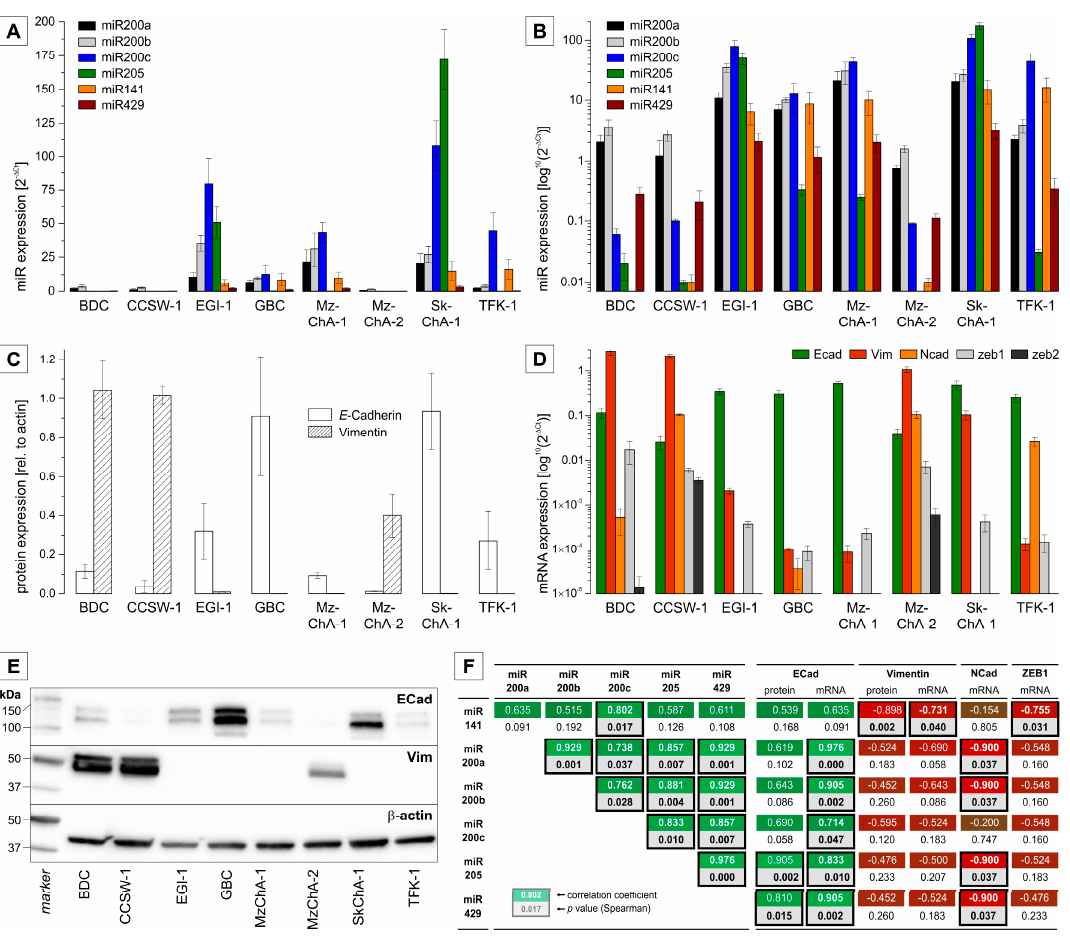
Figure 1. Relative expression of miR200 family members, miR205 and EMT-related markers (mRNA, protein) in BTC cell lines. ( A , B ) expression levels of miRs related to RNU6B using a linear ( A ) and a logarithmic ( B ) scale, respectively; ( C ) quantitative protein expression (densitometry) of epithelial marker E -cadherin and mesenchymal marker vimentin; ( D ) mRNA levels of EMT markers related to β -actin; ( E ) representative Western blot images (cropped); ( F ) Spearman correlation analysis of miR expression with miR expression as well as mRNA/protein expression of EMT markers ( E -cadherin, vimentin, N -cadherin, ZEB1). The first numeric value in each analysis (rectangle) represents the correlation-coefficient ( green for positive correlation, red for negative correlation), the second represents the p -value (highlighted grey when significant). Rectangles of significant correlations are highlighted by a black border. Abbreviations: BTC: biliary tract cancer; Ecad: E -cadherin; EMT: epithelial to mesenchymal transition; miR: MicroRNA; Vim: Vimentin.